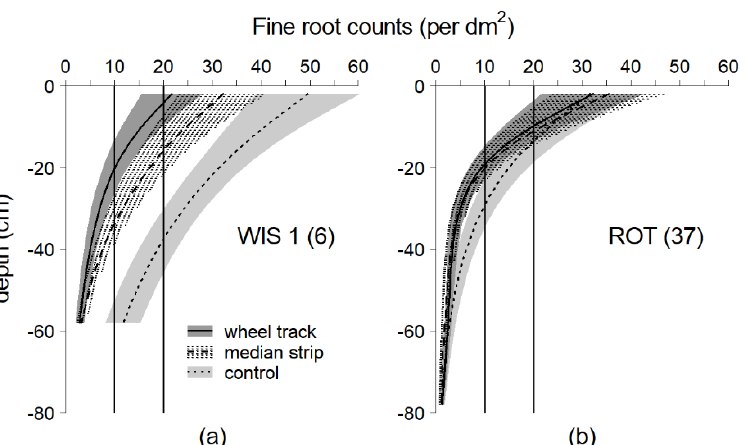
Figure 8. Depth gradients of the mean fine root densities at WIS 1 ( a ) and ROT ( b ) for wheel track, median strip, and control strata. Confidence intervals were calculated using the standard deviations of the GAM predictions (±2 sd). The bold vertical reference lines indicate the boundaries for intense rooting (20 fine roots × 100 cm –2 ); the finer reference lines the threshold for weak rooting (10 fine roots × 100 cm –2 ).